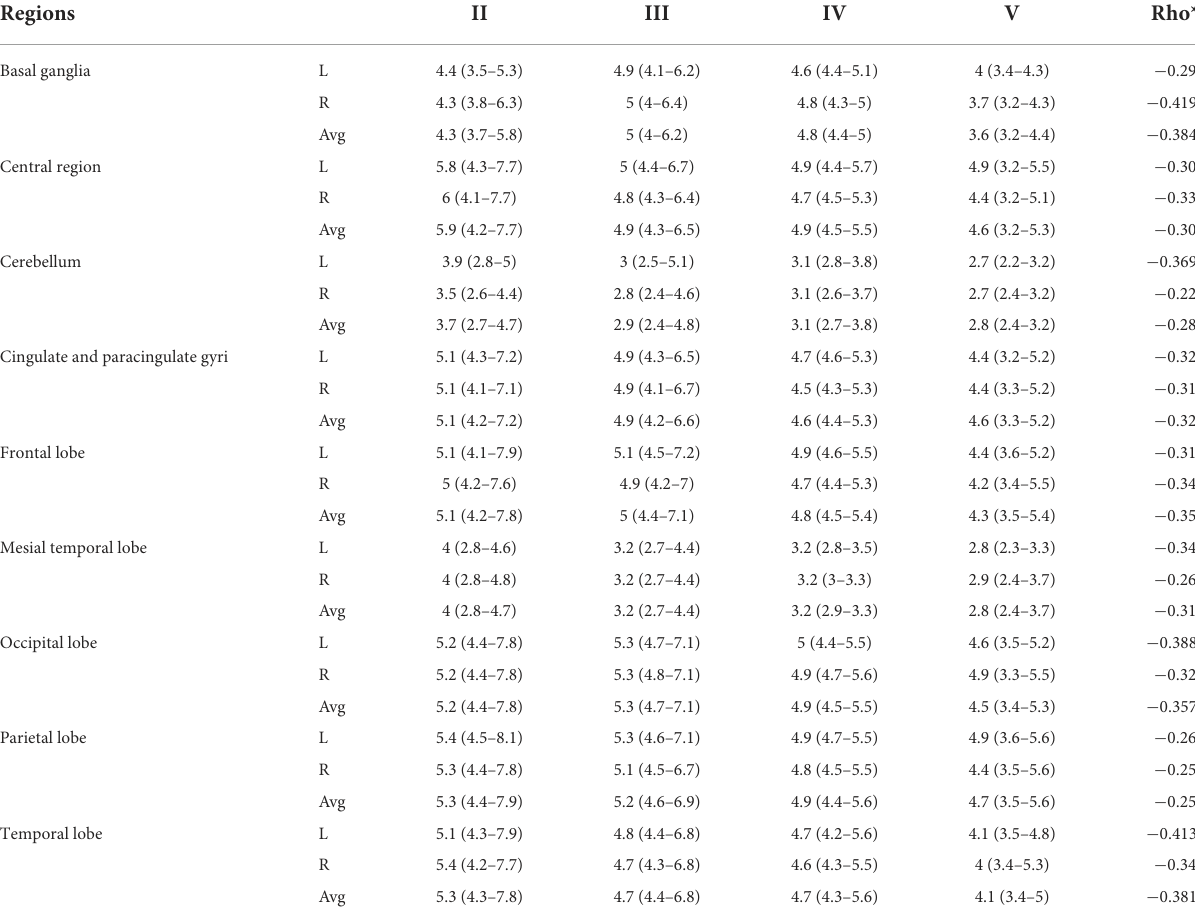
TABLE 3 Association between the regional 18 F-FDG uptake as obtained by volume of interest (VOI) analysis and the GMFCS levels of the CP patients ( n = 31).